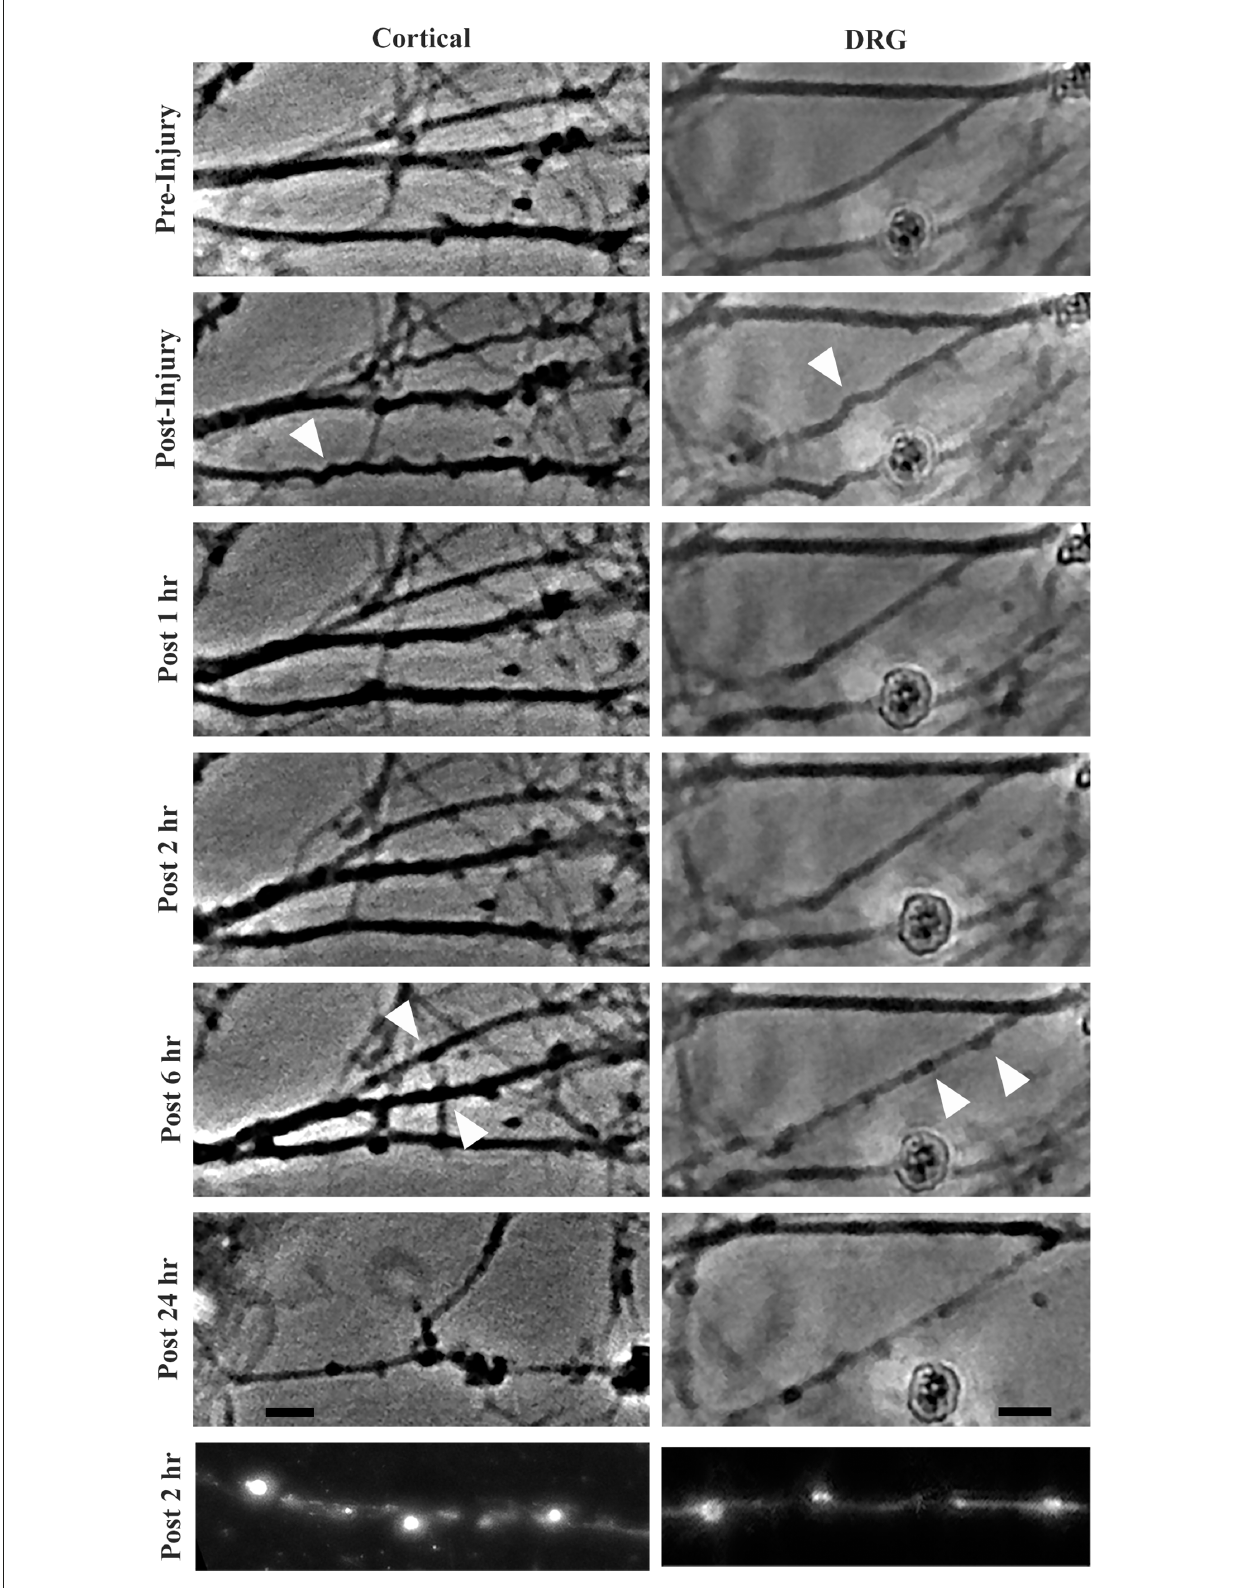
FIGURE3 Morphological changes in cortical and DRGN axons after stretch injury of 60% strain. Time course illustrates that undulations are formed after an injury that are fully recovered at 1 h in both cortical and DRGN axons (arrows). At the 2 and 6 h time points, swellings along the axons develop (arrows). After 24 h, axon degeneration and disconnection were identified in both Cortical and DRGN axons. Bottom row, axons labeled for NF-200 show swellings along the axon in both cortical and DRGN axons at 2 h post injury. Scale bars = 10 µ